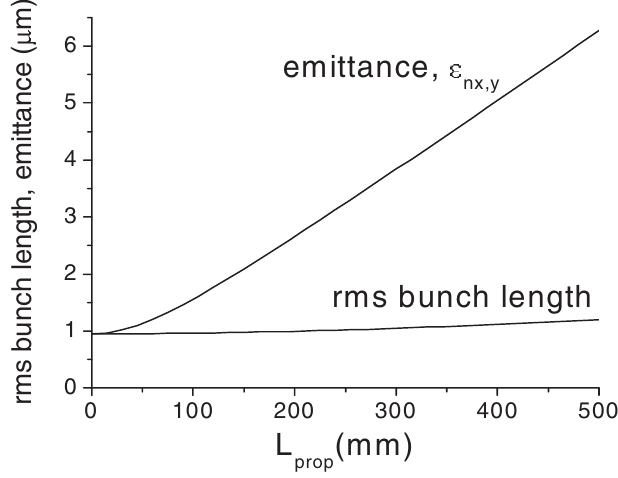
FIG. 8. Evolution of the bunch emittance and rms bunch length in vacuum for the case simulated in Fig.